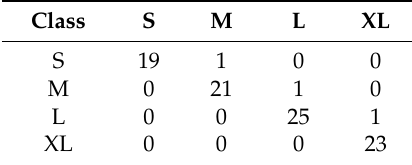
Table 6. Confusion matrix of mass prediction through an estimated